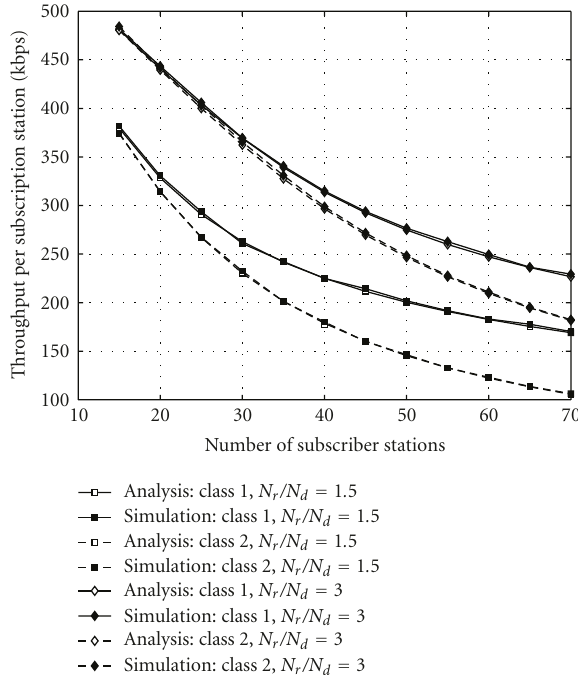
Figure 1: Throughput of single SS versus the number of SSs with equal bandwidth allocation priority and di ff erentiated channel access parameters: W 0,1 = W 0,2 = N r , W x ,1 = 2 4 W 0,1, and W x ,2 = 2 8 W 0,2